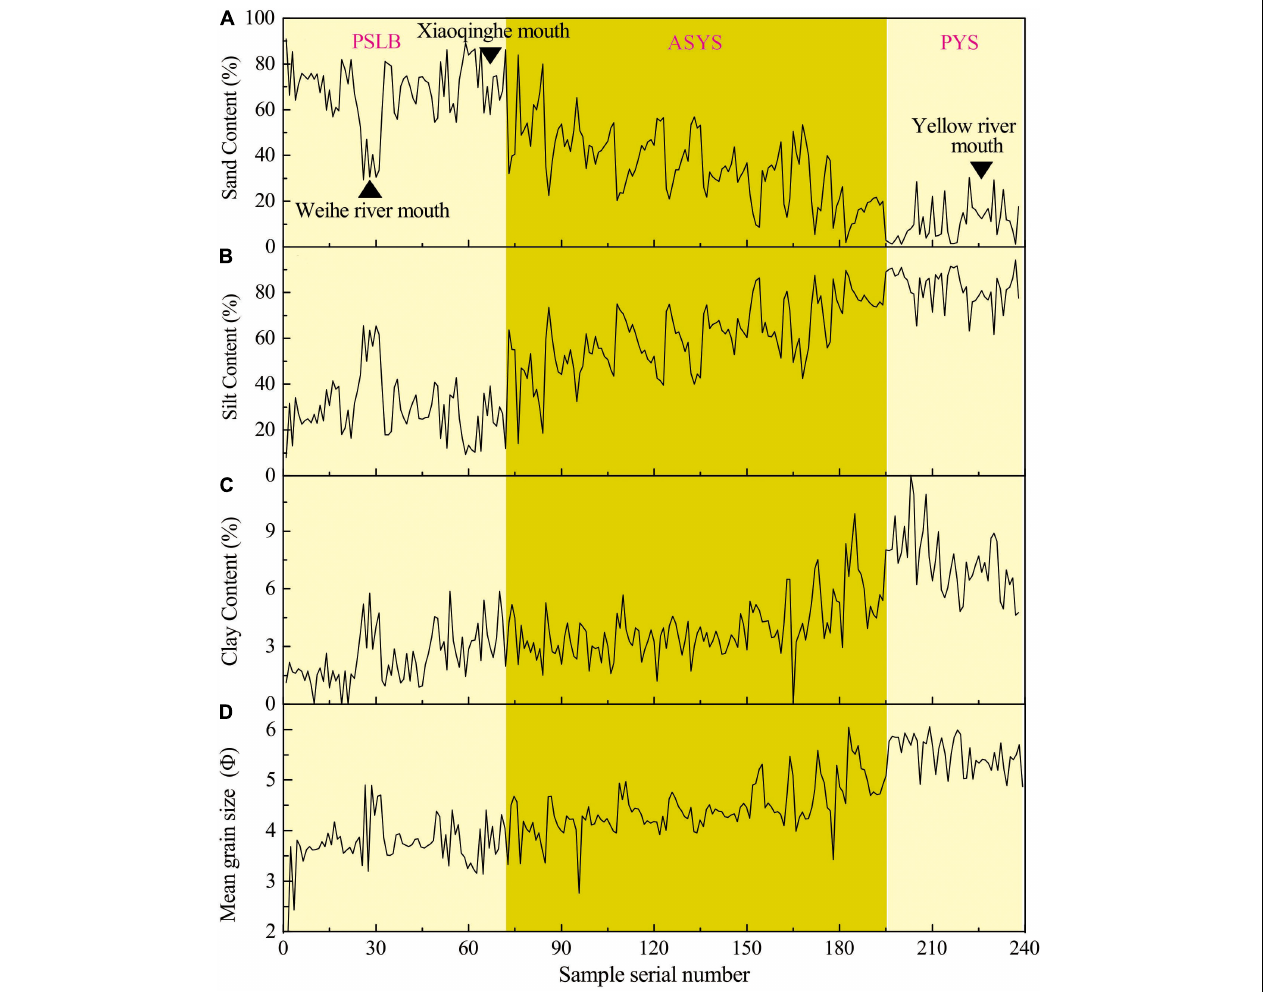
FIGURE 2 | The change curves of sand content (A) , silt content (B) , clay content (C) and mean grain size (D) of tidal flat surficial sediments from ASYS and adjacent zones.